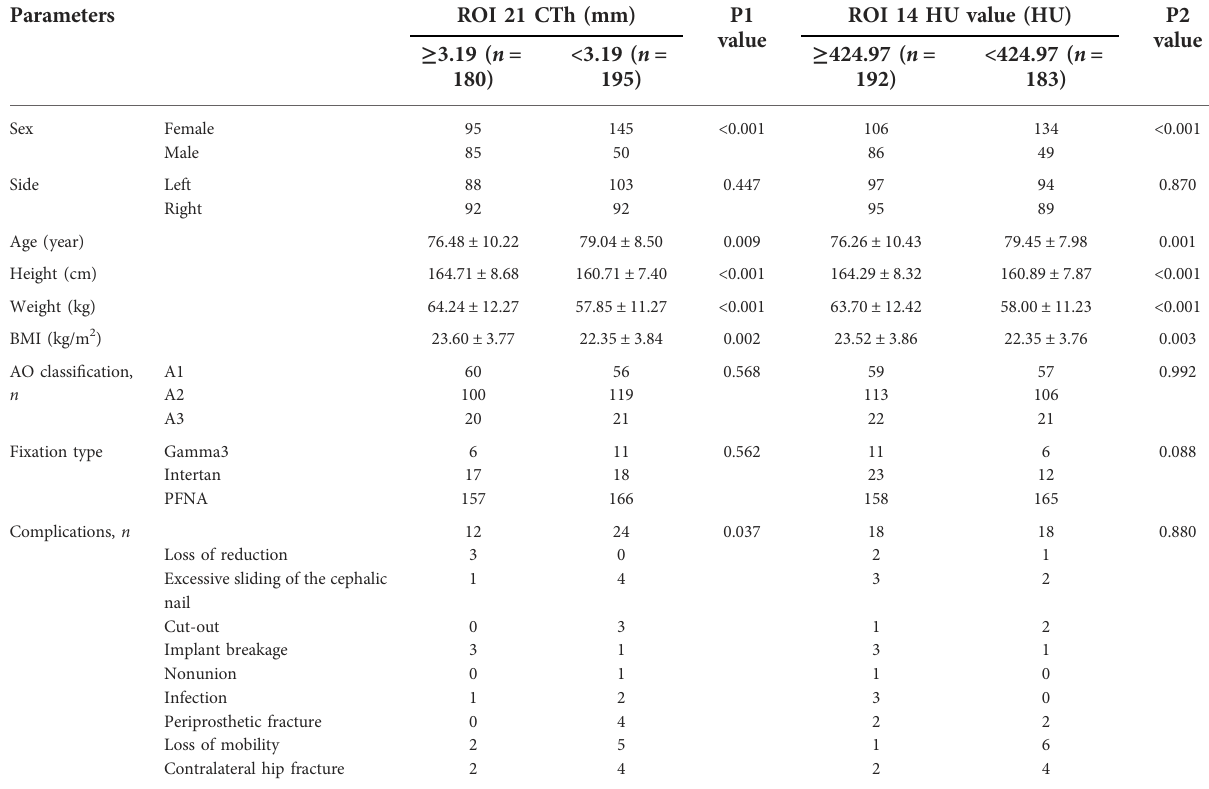
TABLE 5 Patient demographics and complications by the group.